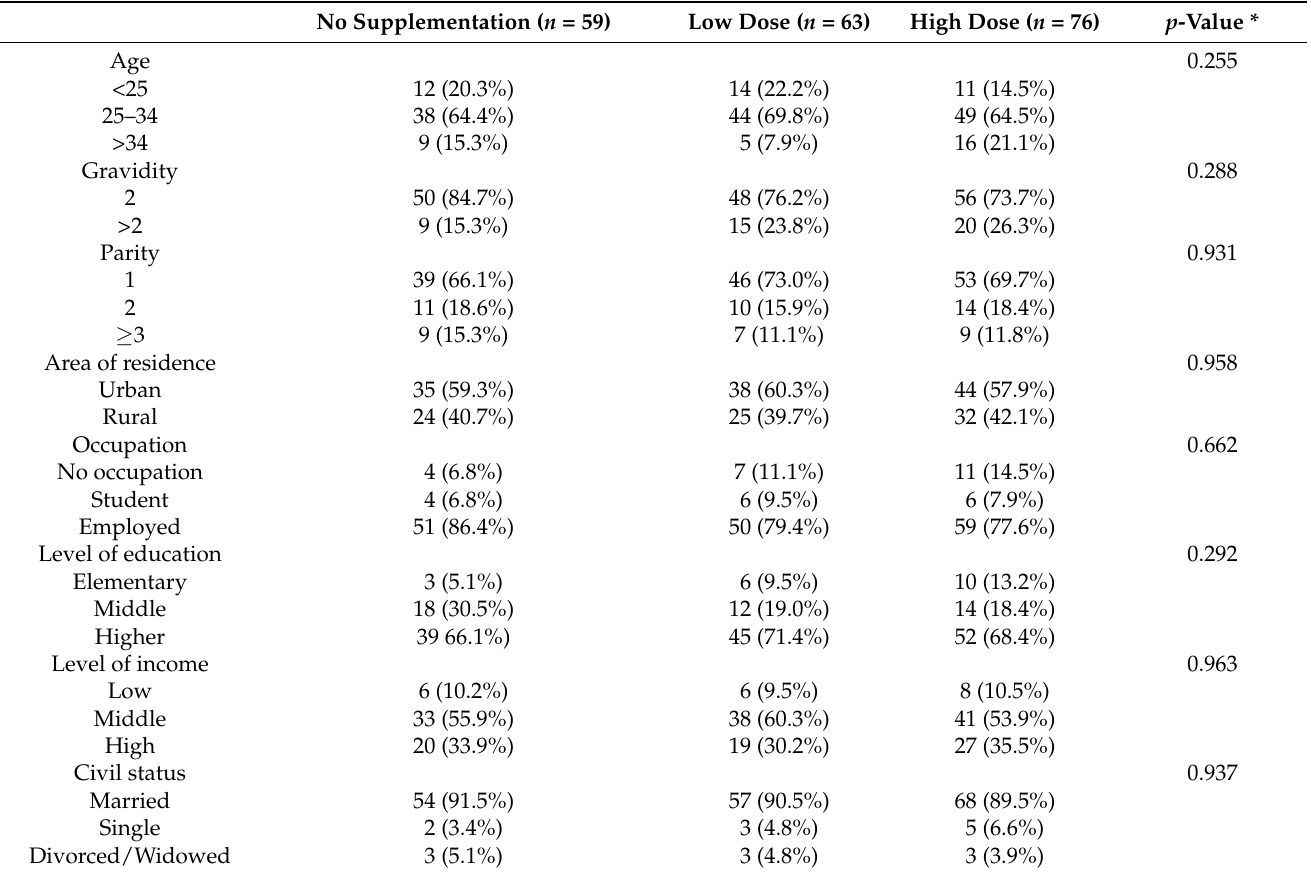
Table 1. Background data of the study cohort stratified by type of vitamin D oral